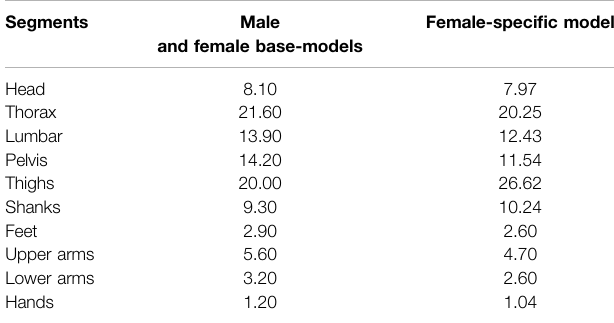
TABLE 3 | Mass distribution of body segments for male and female base-models as well as female-speci fi c model. Values are expressed as the percentage of total body mass (% of